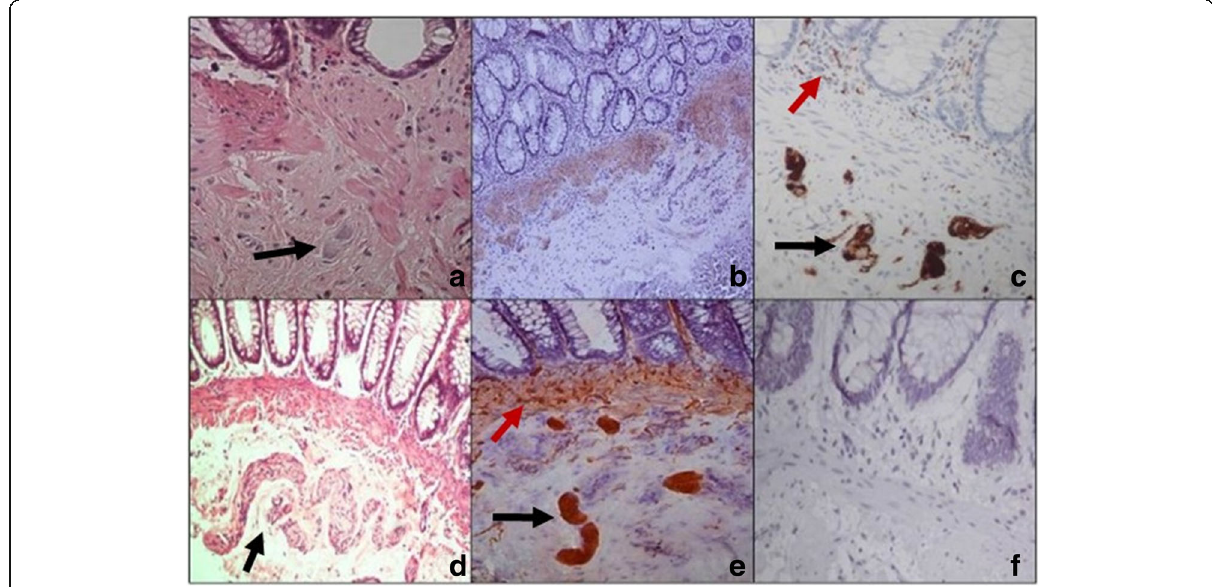
Fig. 1 Histological patterns in HD disease - a HD negative by HE staining: ganglion cells located in the submucosal region (black arrow) at a magnification of 40×; b HD negative by AChE assay at a magnification of 10×; c HD negative by calretinin staining: ganglion cells (black arrow) and nerve fibers (red arrow) in the lamina propria at a magnification of 10×; d HD positive by HE staining: nerve trunks in the submucosal region (black arrow) at a magnification of 10×; e HD positive by AChE assay: nerve trunks (black arrow) and fibrils (red arrow) at a magnification of 20×; f HD positive by calretinin staining at a magnification of